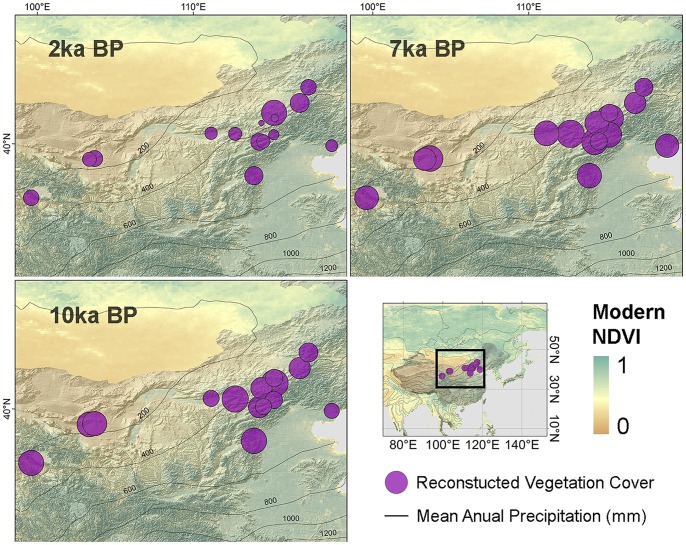
Reconstructed vegetation cover, related factors and prescribed values in previous studies.
Vegetation Cover shows the reconstructed NDVI averaged from 15 sequences, with linear regression after 6.5 ka yr BP showing a decrease of 0.13. The light green area indicates the upper quartile and lower quartile of the 15 sequences, indicating that areas with higher NDVI experience larger fluctuations and were the major contributors to the vegetation decline in Period II. Sand% of AN shows the coarse sand (>63 μm) percentage in sediment cores from Anguli Nuur (inversely scaled). Stalagmite δ18O of Dongge Cave (as δ18O, values are negative), coarse sand percentage of Anguli Nuur and reconstructed NDVI are significantly correlated with each other. Prescribed values in the model simulation by Dallmeyer and Claussen (2011) coincide with the vegetation cover at 6.5 cal ka BP as reconstructed here; the colour bar shows the percentage of grass/trees in comparison to the modern vegetation distribution.